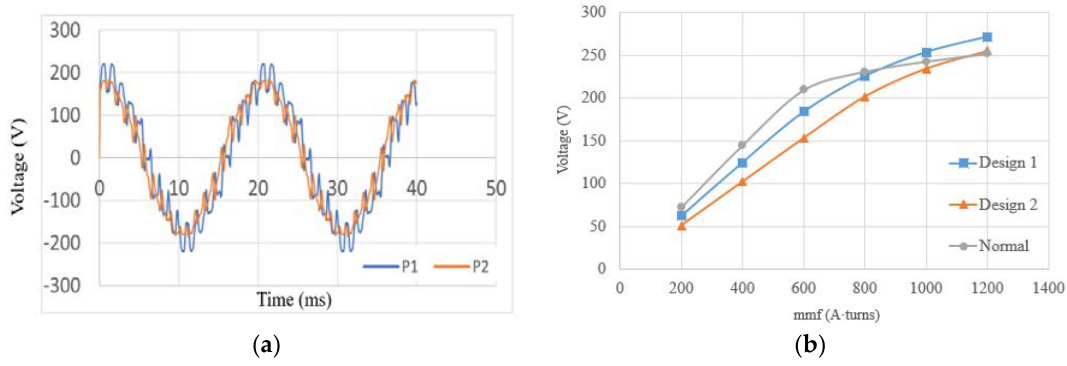
Figure 8. Comparison of two optimized rotor topologies. ( a ) Induced Electromagnetic motive force